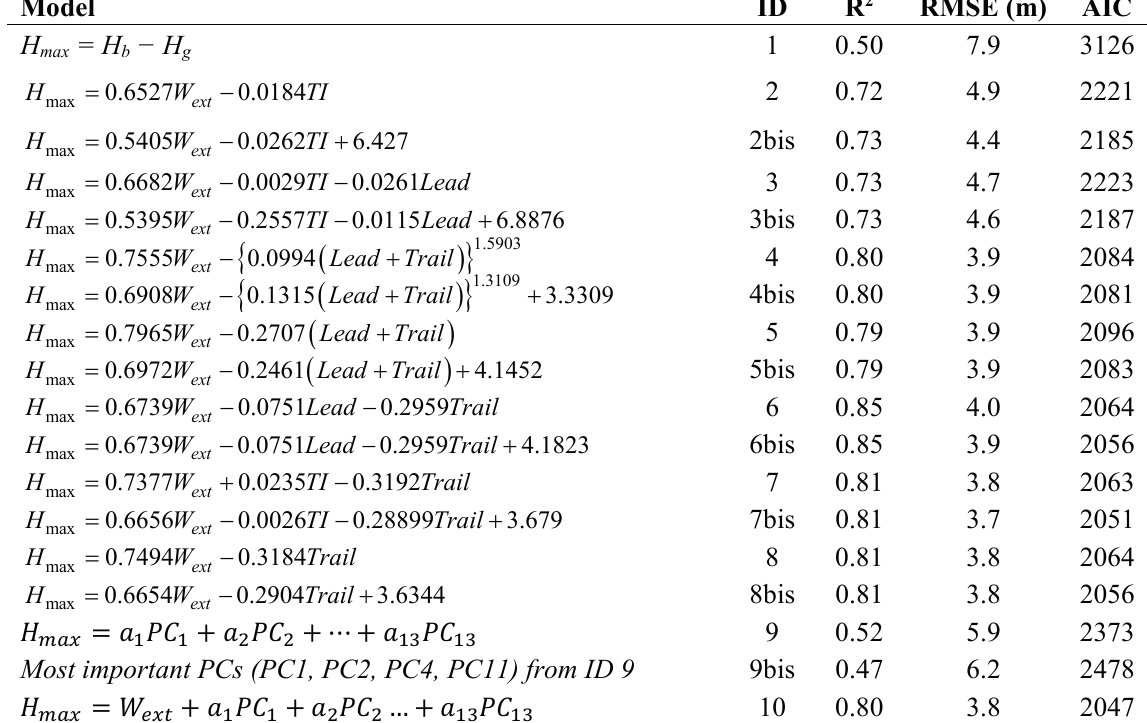
Table 2. Regression models’ fitting statistics calculated with 10-fold cross validation for estimating forest height. R = root mean square error, AIC = Akaike information